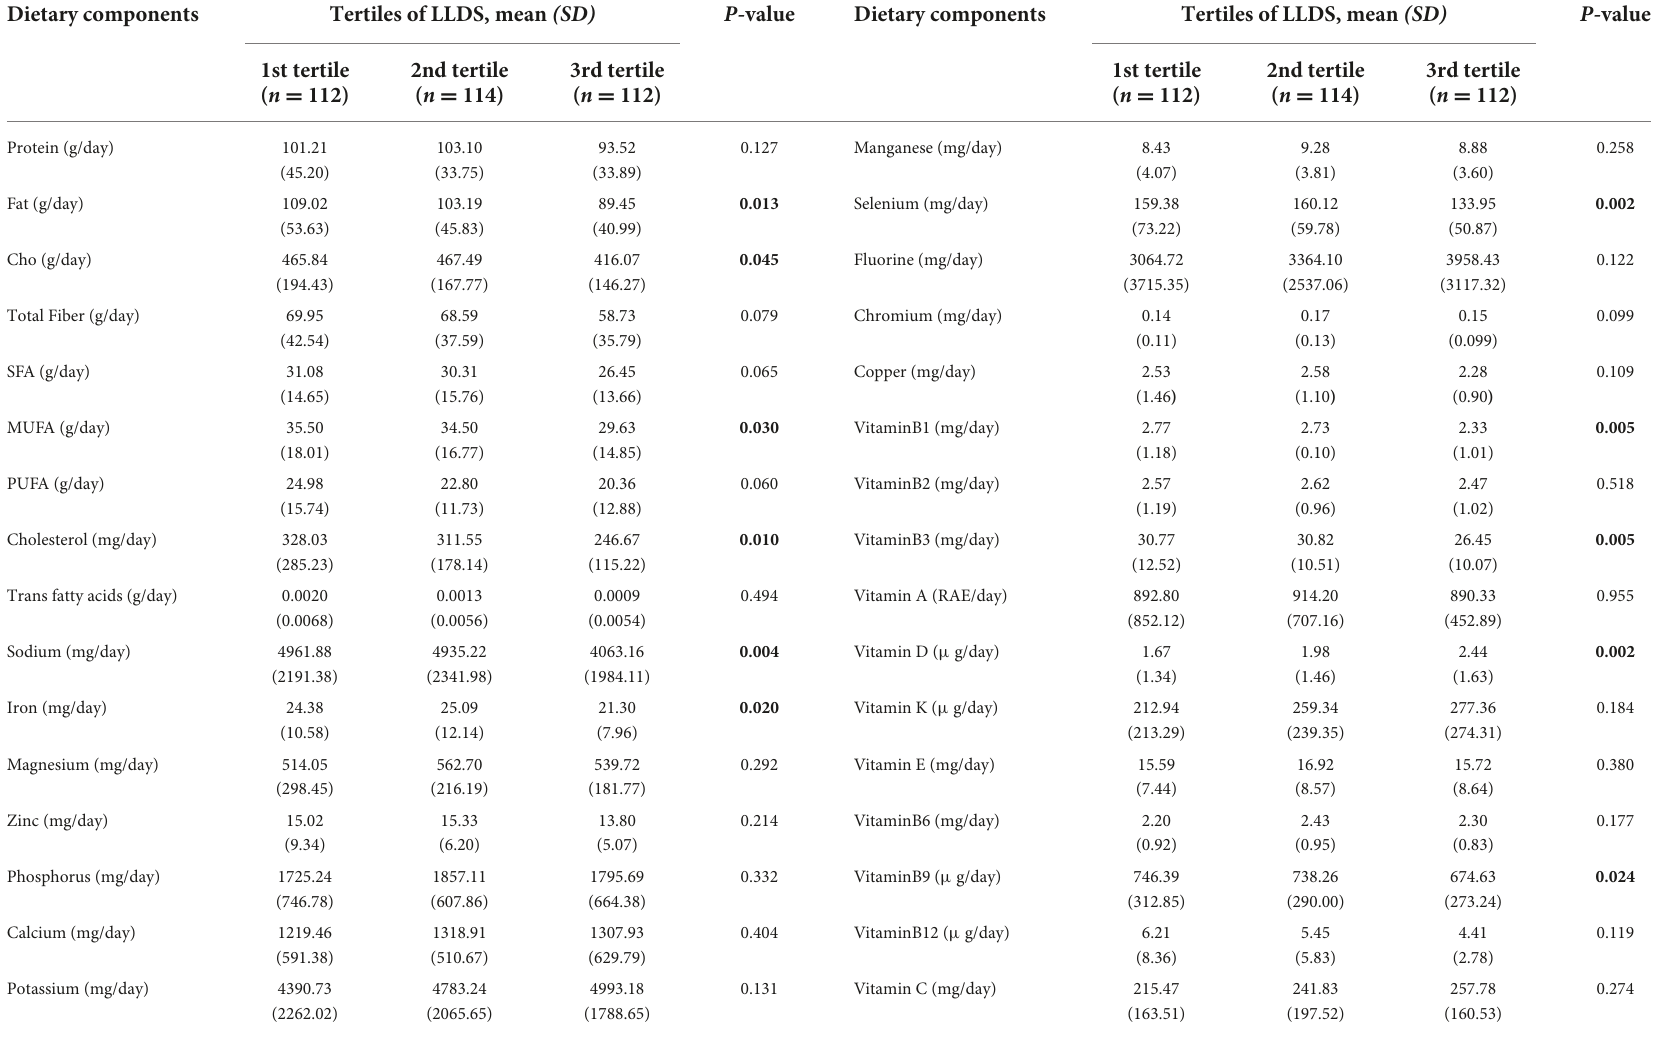
TABLE 3 Dietary intakes of participants across different tertiles of LLDS. Dietary